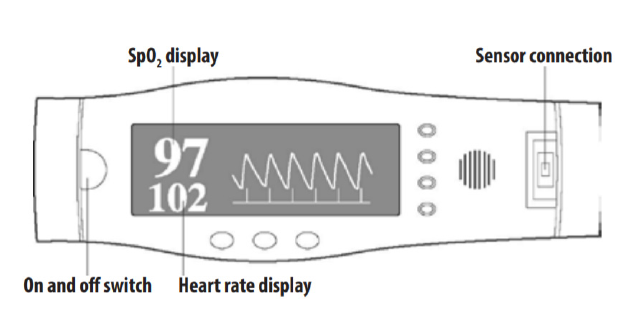
Fig. 2. Valid pulse oximeter reading with normal pulse trace; SpO : Oxygen saturation of hemoglobin 2 in the arterial blood as estimated by the pulse oximeter. [Reproduced from WHO 2020. (https:// www.who.int/publications-detail/clinical-care-of- severe-acute-respiratory-infections-tool-kit) (CC BY-NC-SA 3.0